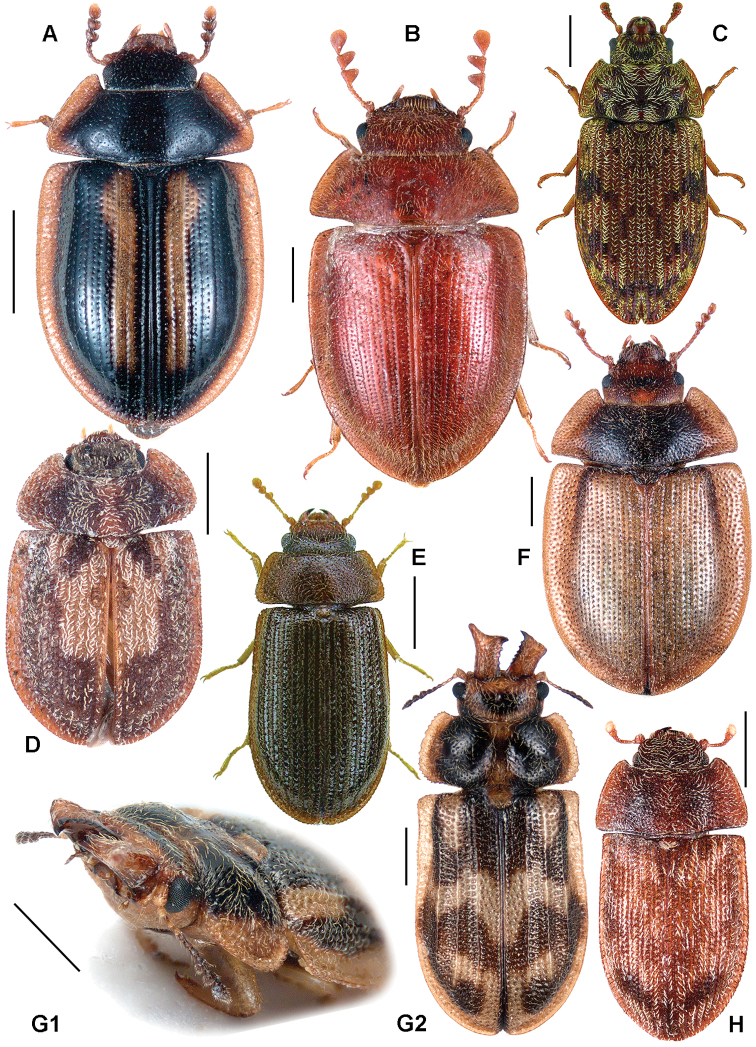
A
Ancyrona (syn. Latolaeva) bivittata
B
Ancyrona vicina
C
Ancyrona kosnovskorum (= fairmairei?) D
Ancyrona sp., lewisi-group, Malaysia E
Ancyrona japonica, Slovakia F
Ancyrona gabonica
G
Leptonyxa fairmairei
H
Neaspis variegata.